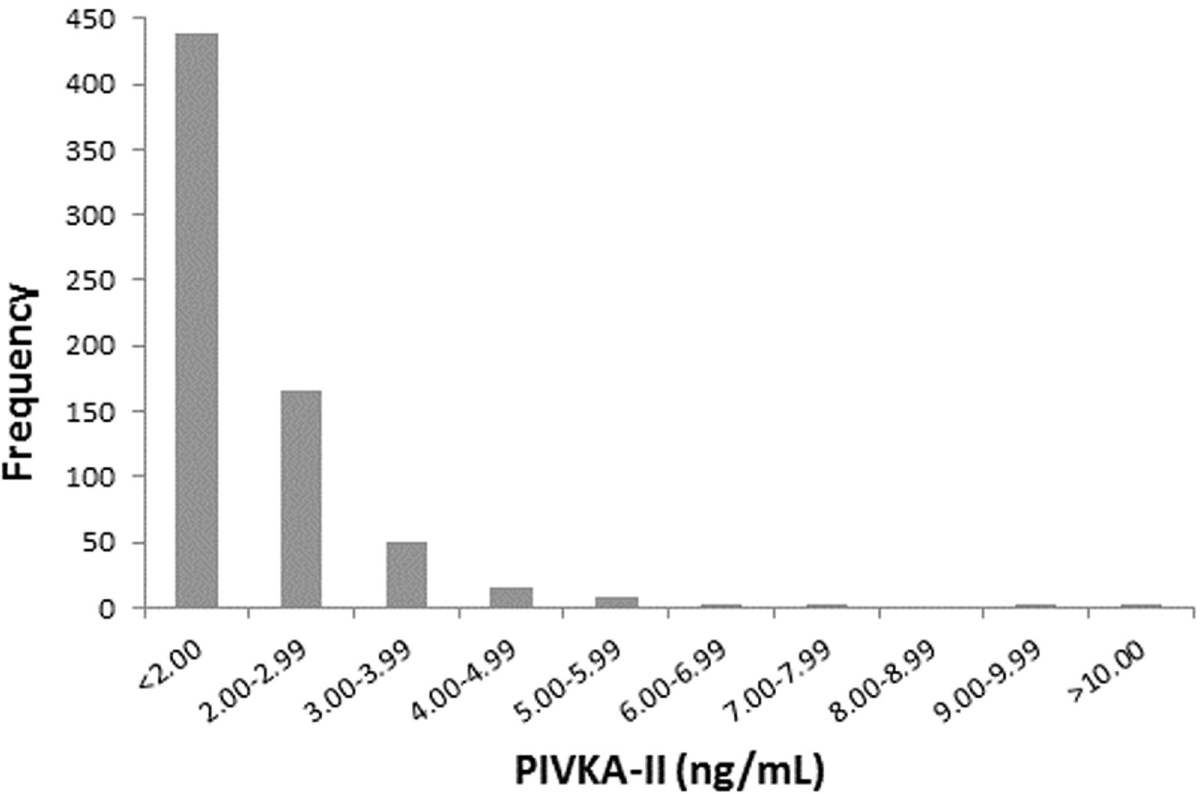
Fig 5. Frequency distribution of plasma PIVKA-II (N = 682). 36.2% of samples had PIVKA-II concentrations equal to or above2.0 ng/mL. Two values not includedwere outlierswith plasma levels of 1618 and 1708 ng/mL.